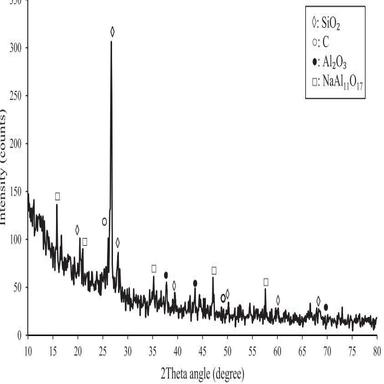
XRD pattern of solid residue at the end of extraction process.